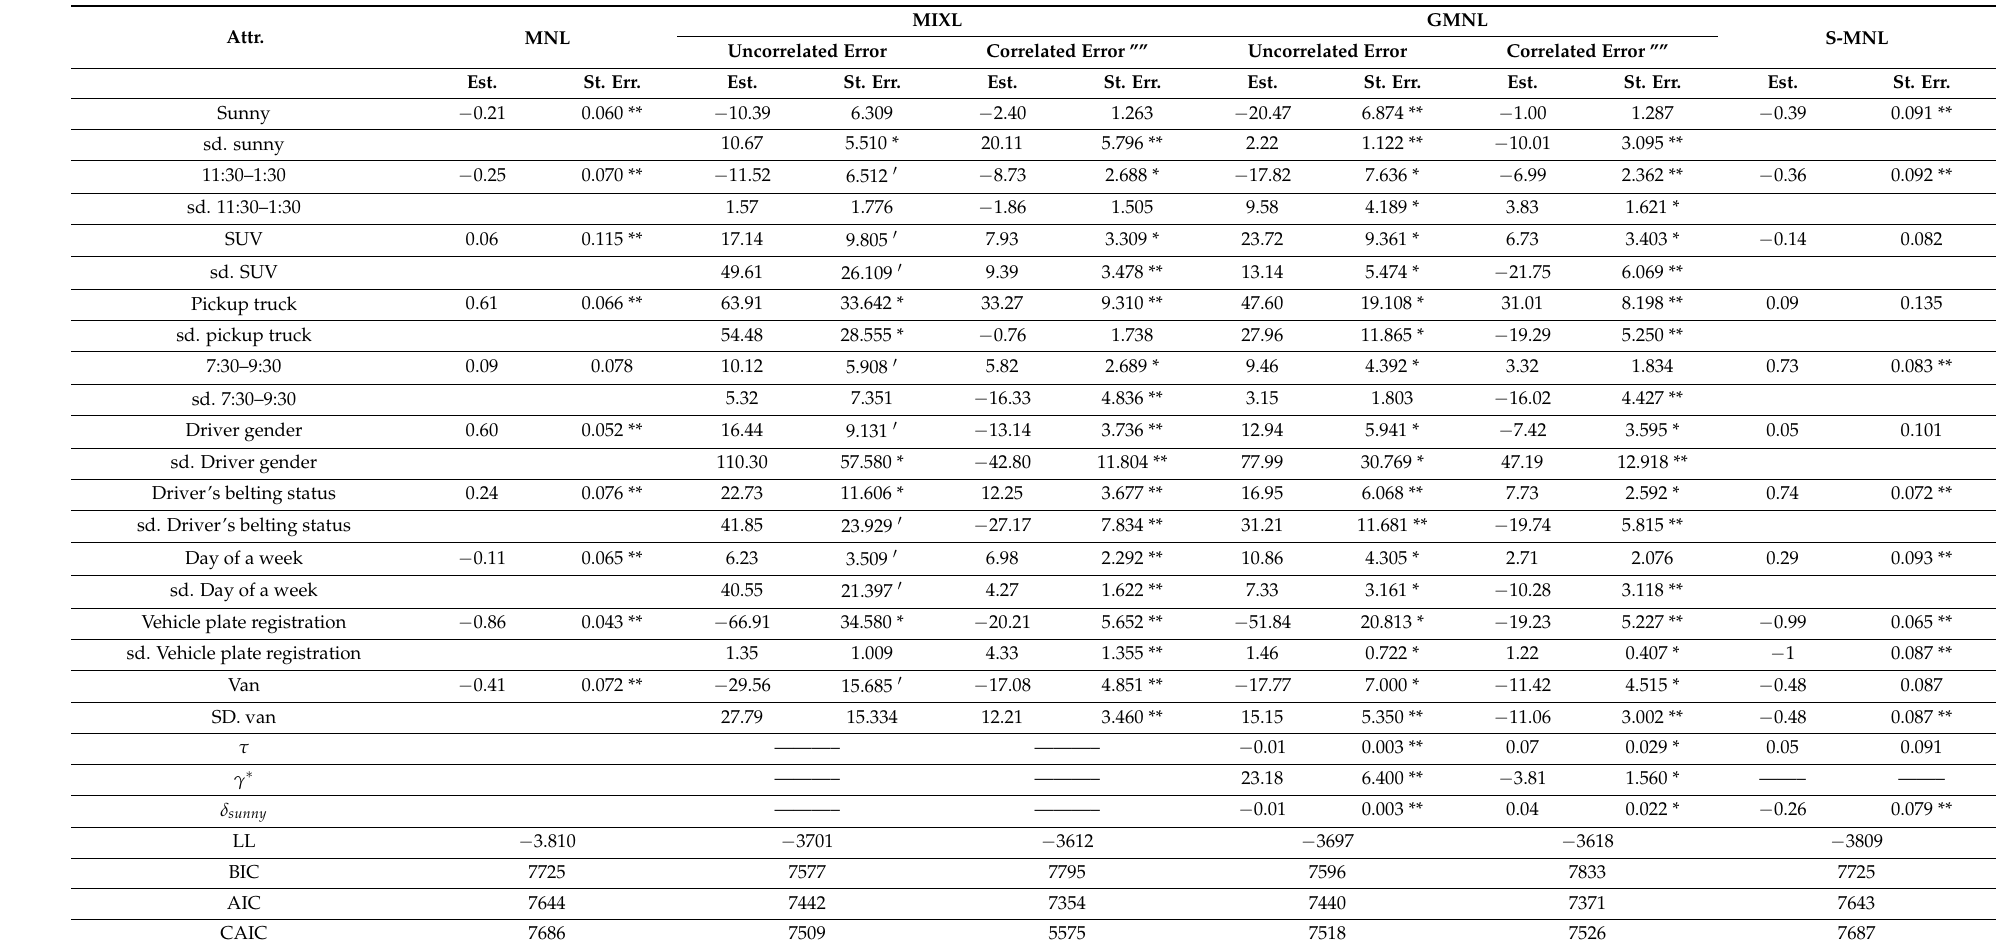
Table 2. Model parameters estimates of considered